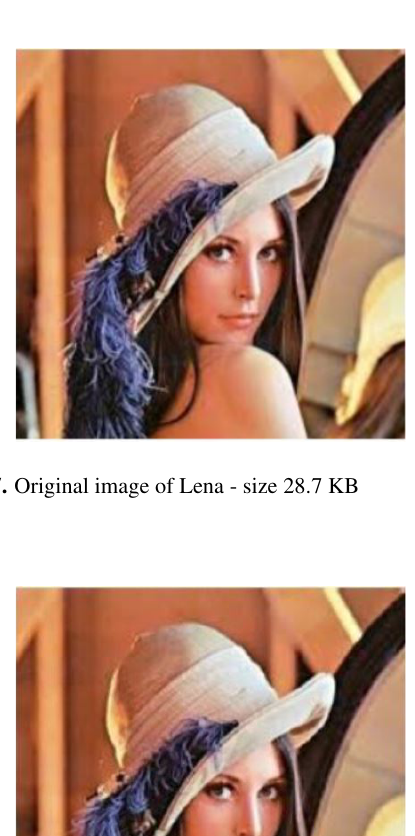
Figure 5. DECRYPTION PROCESS